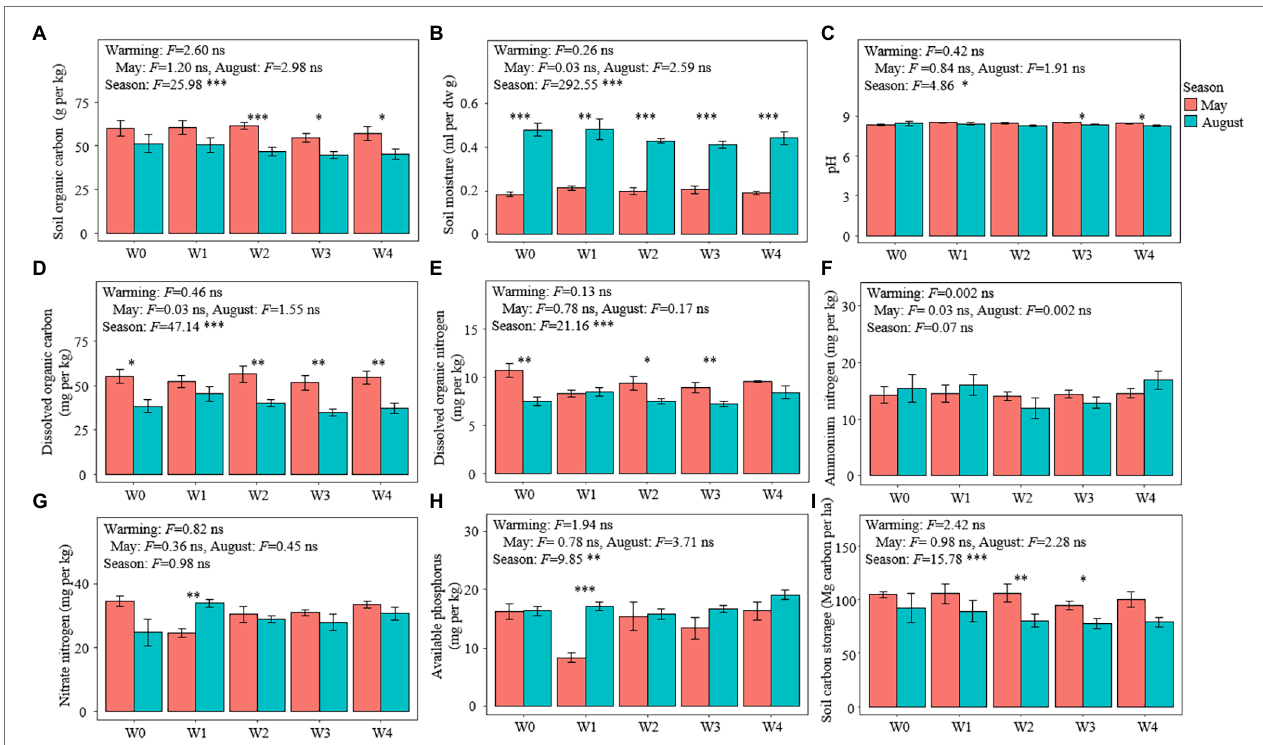
FIGURE 1 | Soil characteristics in the different treatments. (A) Soil organic carbon content, (B) soil moisture, (C) pH, (D) dissolved organic carbon content, (E) dissolved organic nitrogen content, (F) ammonium nitrogen content, (G) nitrate nitrogen content, (H) available phosphorus content, and (I) soil carbon storage. Bars represent the means ± SE ( n = 5). Significant differences among the treatments were tested using Tukey’s honest significant difference test ( p ≤ 0.05). The F - values and significance shown correspond to the linear mixed-effects model. * p < 0.05, ** p < 0.01, *** p < 0.001. SE, standard